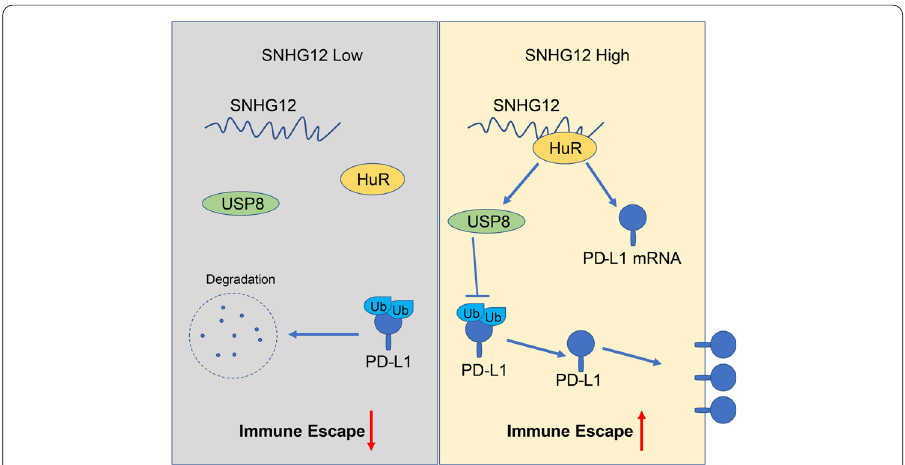
Fig. 10 Mechanism of lncRNA SNHG12 in immune escape of NSCLC. SNHG12 was highly expressed in NSCLC. On the one hand, SNHG12 bound to HuR to improve mRNA stability and expression of PD-L1. On the other hand, lncRNA SNHG12 bound to HuR to improve mRNA stability and expression of USP8. USP8-mediated deubiquitination increased the protein level of PD-L1, consequently promoting immune escape of